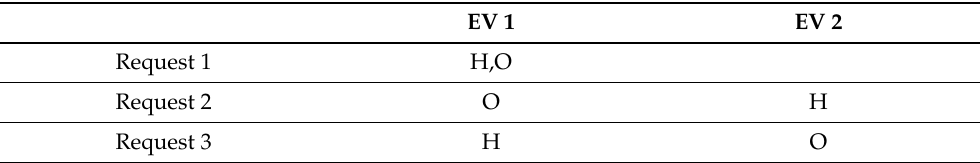
Table 3. Request assignment in Example